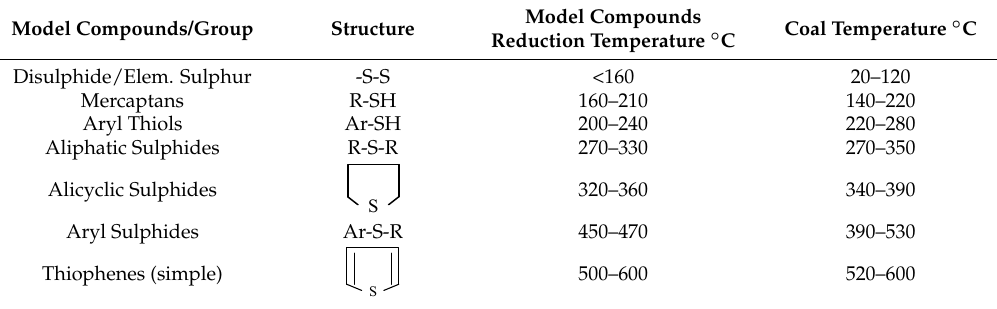
Table 2. Reduction temperatures for organic sulphur groups.